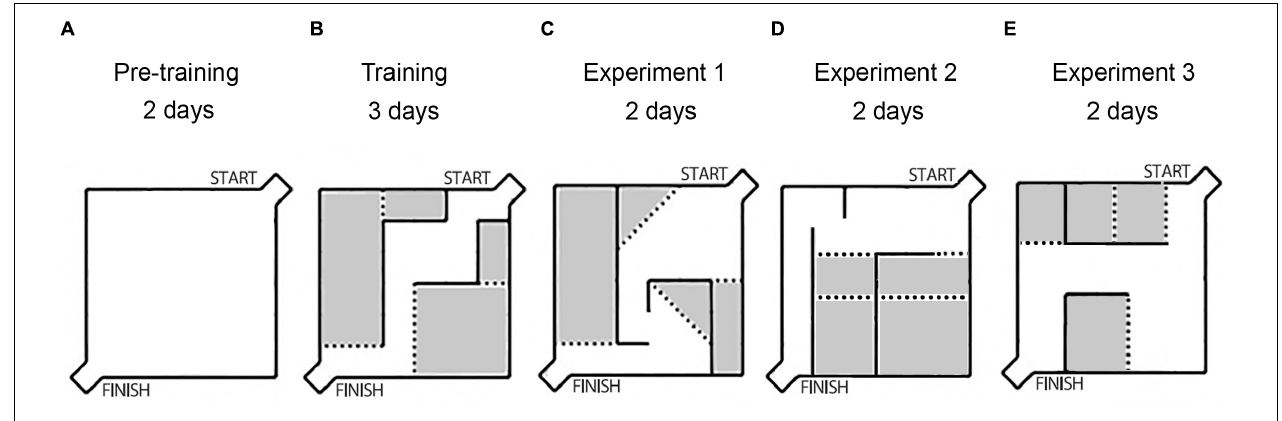
FIGURE 1 | The scheme of the experiments: layouts of the Hebb-Williams maze arenas used in experiments. (A) The wall-less maze (pre-training period). (B) The unchanging walls arena, training period, without any injections. (C) The arena after saline injections. (D) The arena after Guanfacine (GF) injections. (E) The arena after Yohimbine (YOH) injections. The gray color indicates the error zones of the maze.